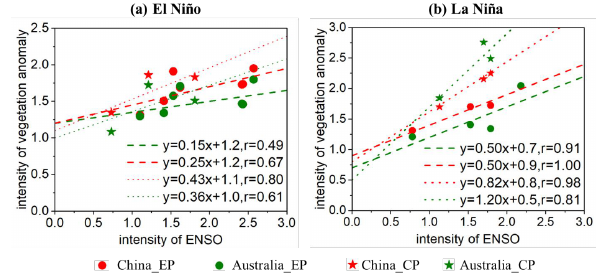
Figure 2 . The relationship between the intensity of vegetation anomalies and different types of ENSO. (a) El Niño; (b) La Niña. Red and green dots indicate EP type events for China and Australia, respectively, while stars indicate CP type events. The dashed and dotted lines indicate linear regressions between the intensity of vegetation anomalies and EP-type and CP-type ENSO events, respectively.